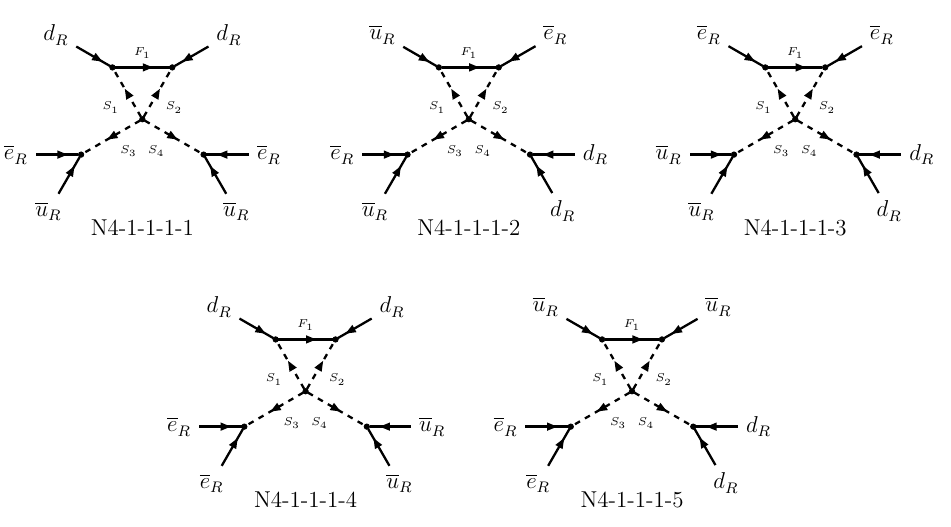
Figure 4 . The possible ways to attach the fields of the operator N4 to the diagram